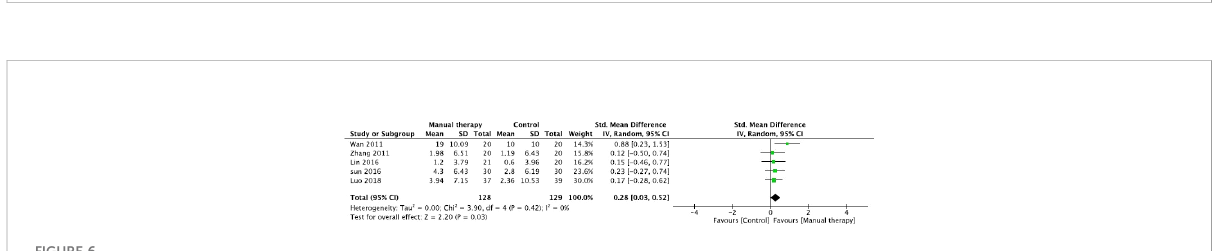
FIGURE 6 Forest plot of the effect of manual therapy plus other conservative therapies for idiopathic scoliosis in Cobb